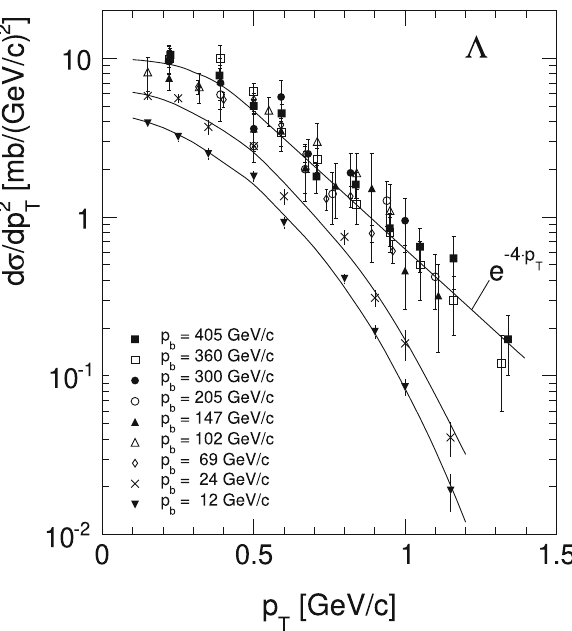
Fig. 12 d σ/ dp 2 as a function of p T for Λ at different beam momenta T